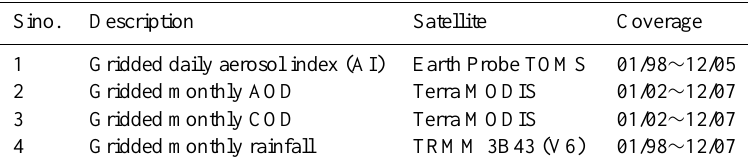
Table 1. List of data products used from different satellite platforms. Sino.